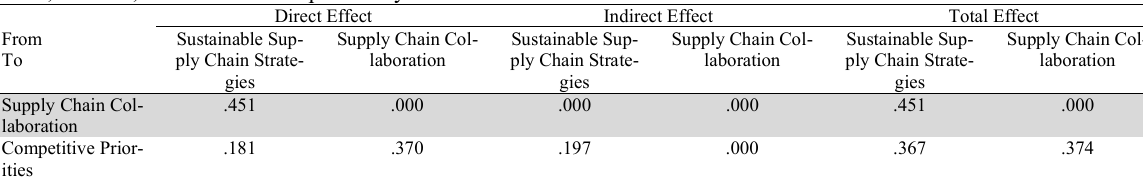
Direct, Indirect, & total effect for path analysis